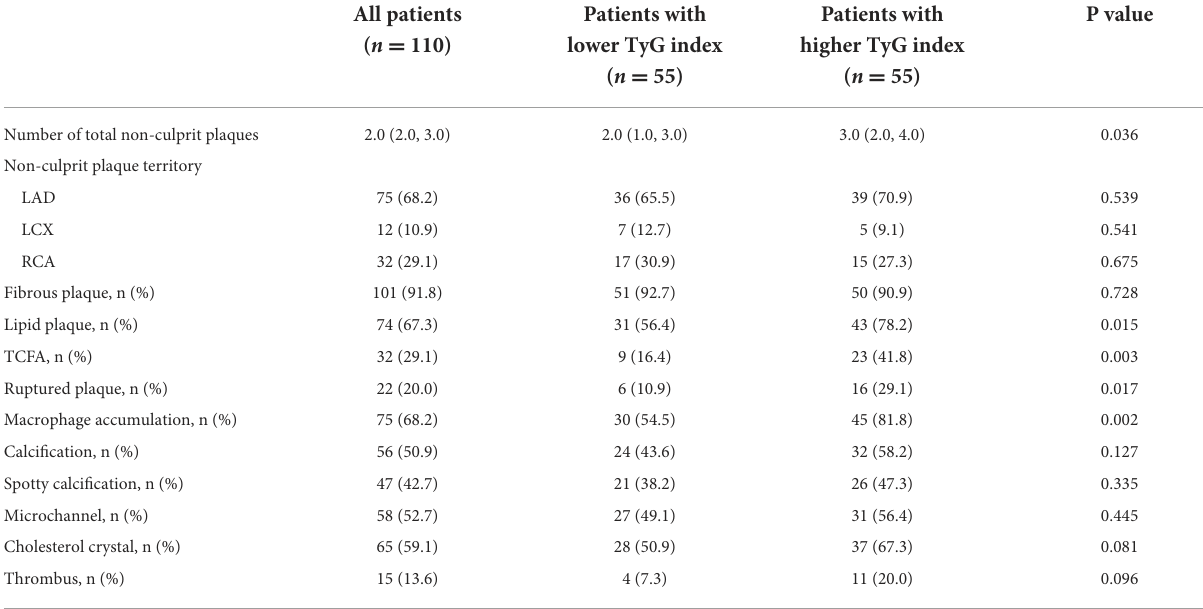
TABLE 2 Patient-level angiographic and OCT analysis of non-culprit plaques comparing lower vs. higher TyG index.